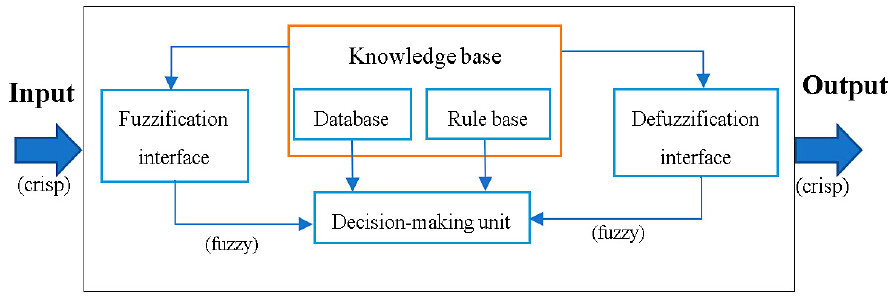
Figure 3. The fuzzy inference system [26].